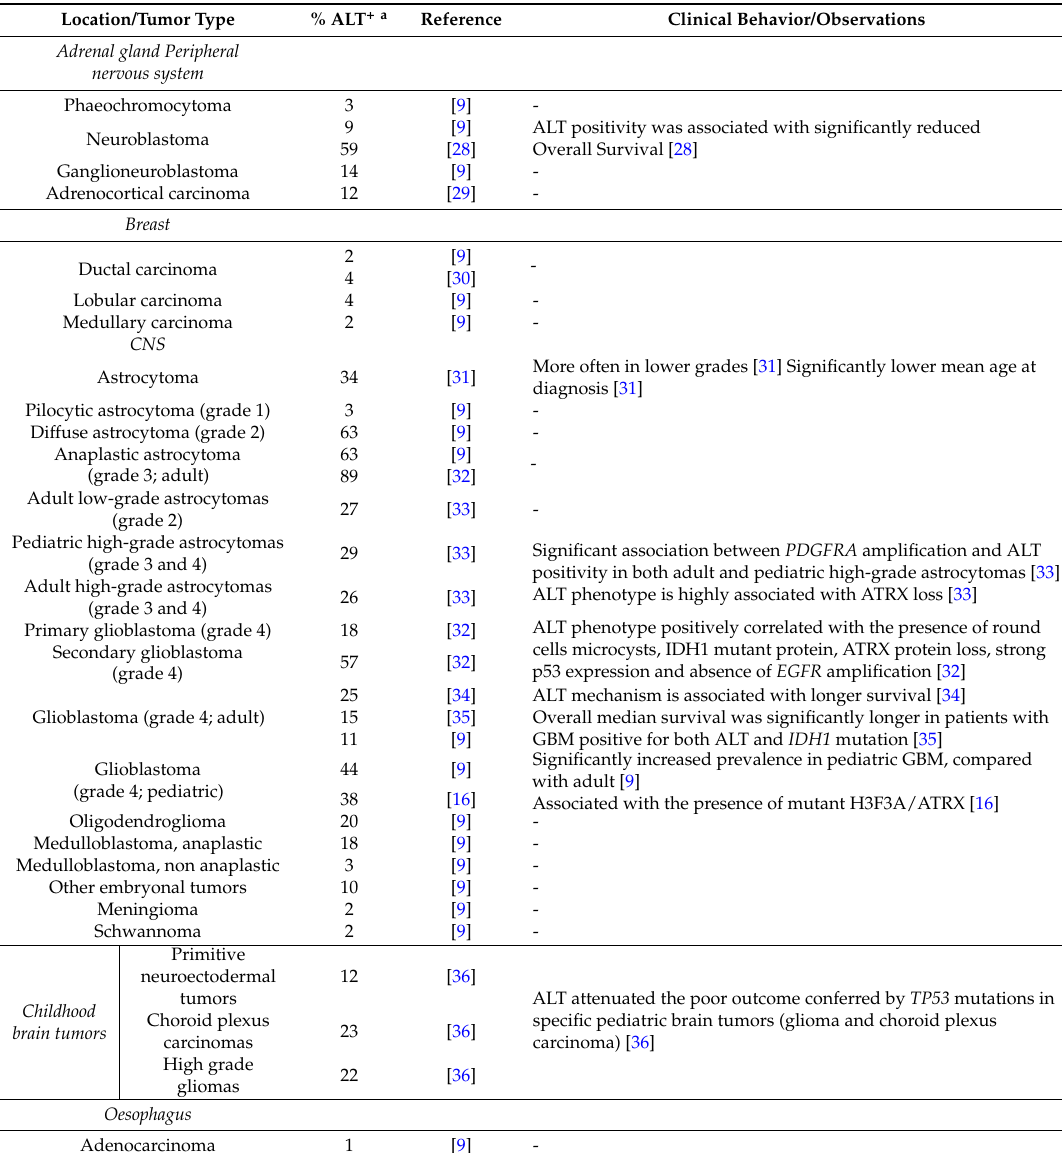
Table 1. Prevalence of the alternative lengthening of telomeres (ALT) phenotype in human cancer